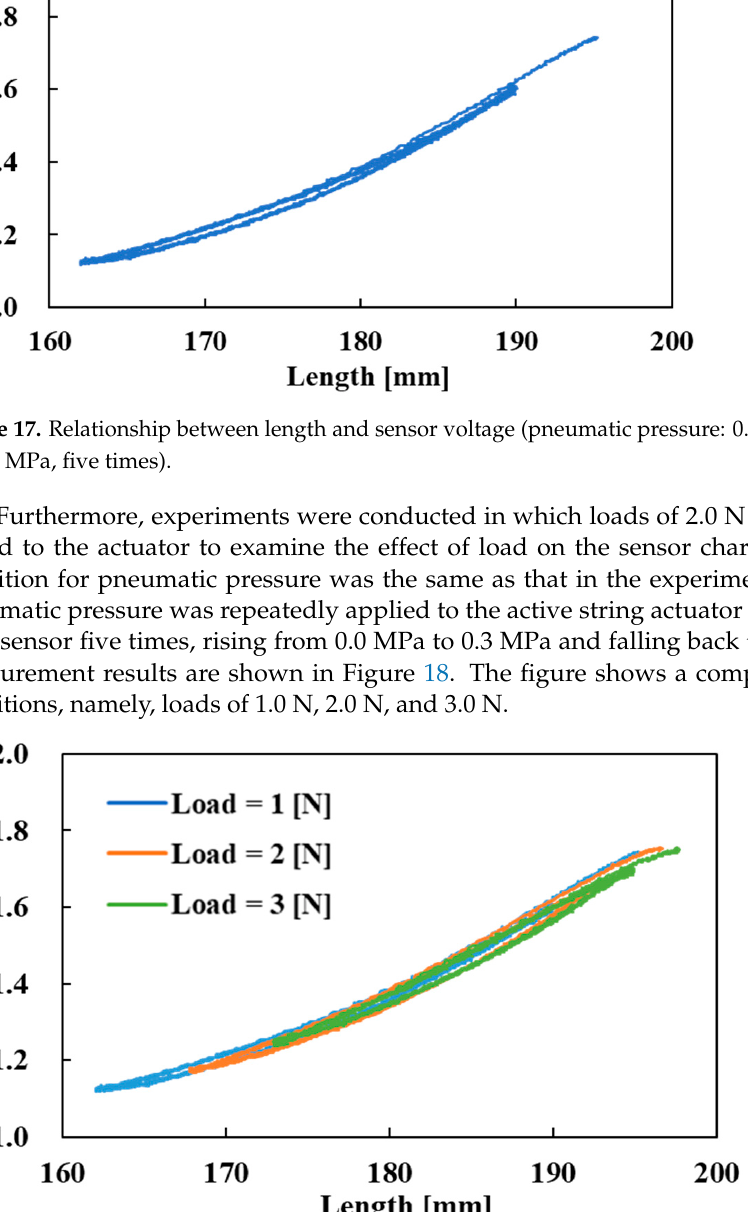
Figure 18. Change in sensor voltage due to load.